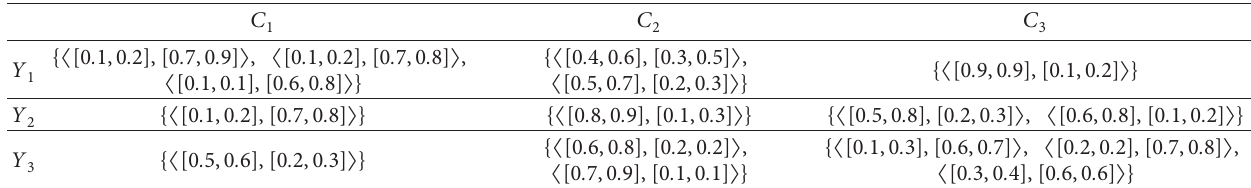
Table 5: IVPHFDM N ( 2 ) .